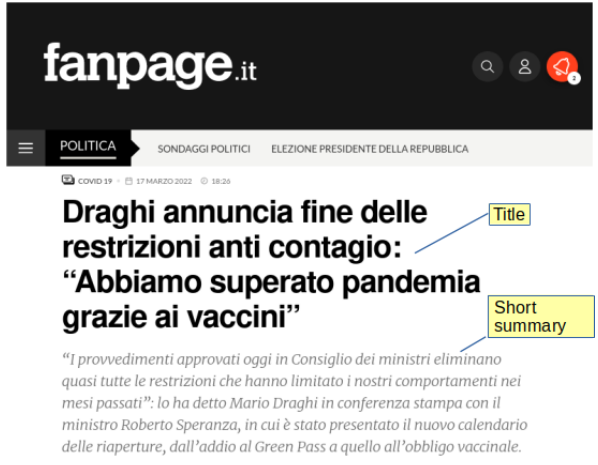
Figure 2. An example of an article downloaded from the Fanpage news website. The figure highlights the title and the short